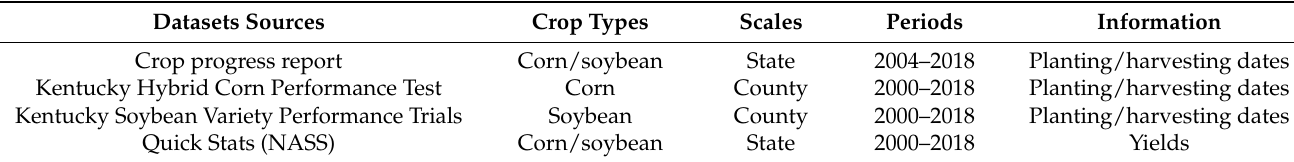
Table 1. Description of datasets used in this